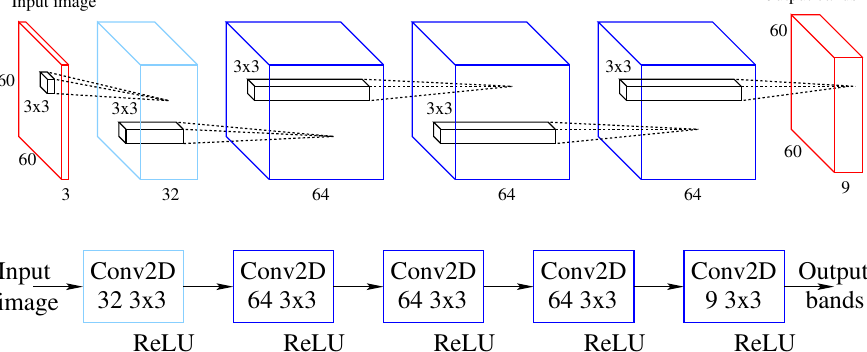
Figure 5. CNN model considered as generator for a Conditional Generative Adversarial Network architecture. In the upper part of the figure the boxes represent features, while in the lower part the boxes represent the network